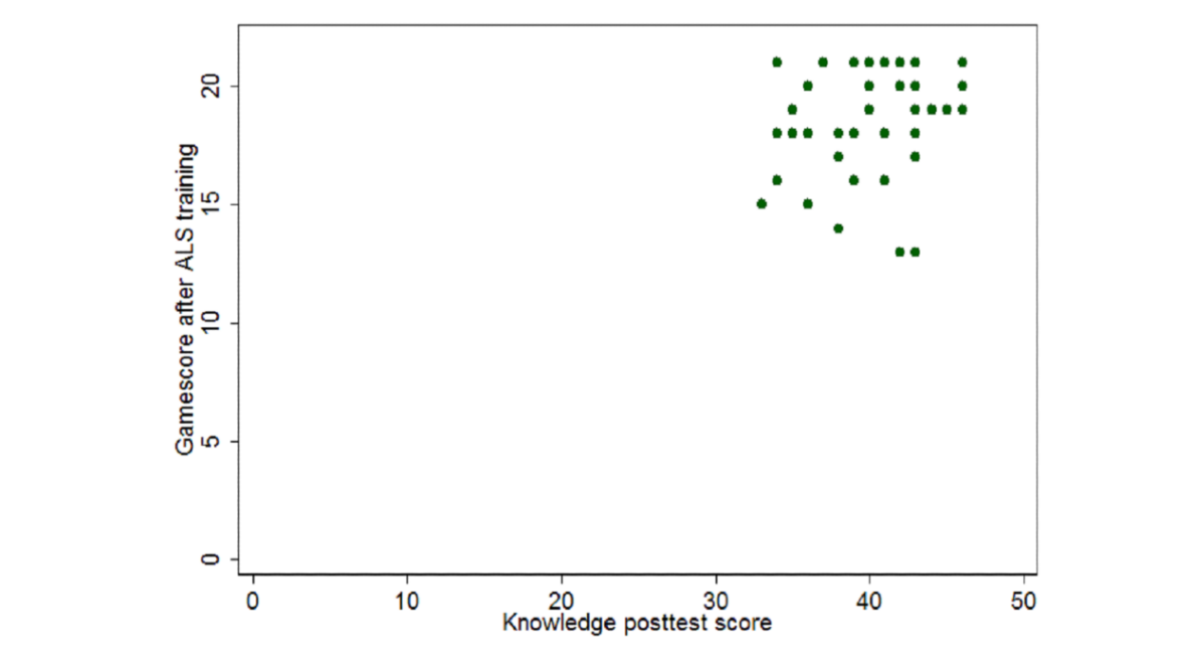
Figure 4. Correlation between game score post-Advanced Life Support training and knowledge posttest score was low ( P =.07,